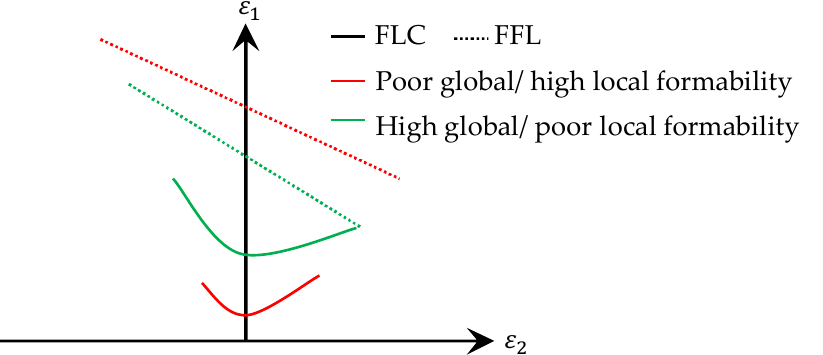
Figure 1. Schematic of FLC and FFL for materials displaying poor global/high local formability and vice versa.